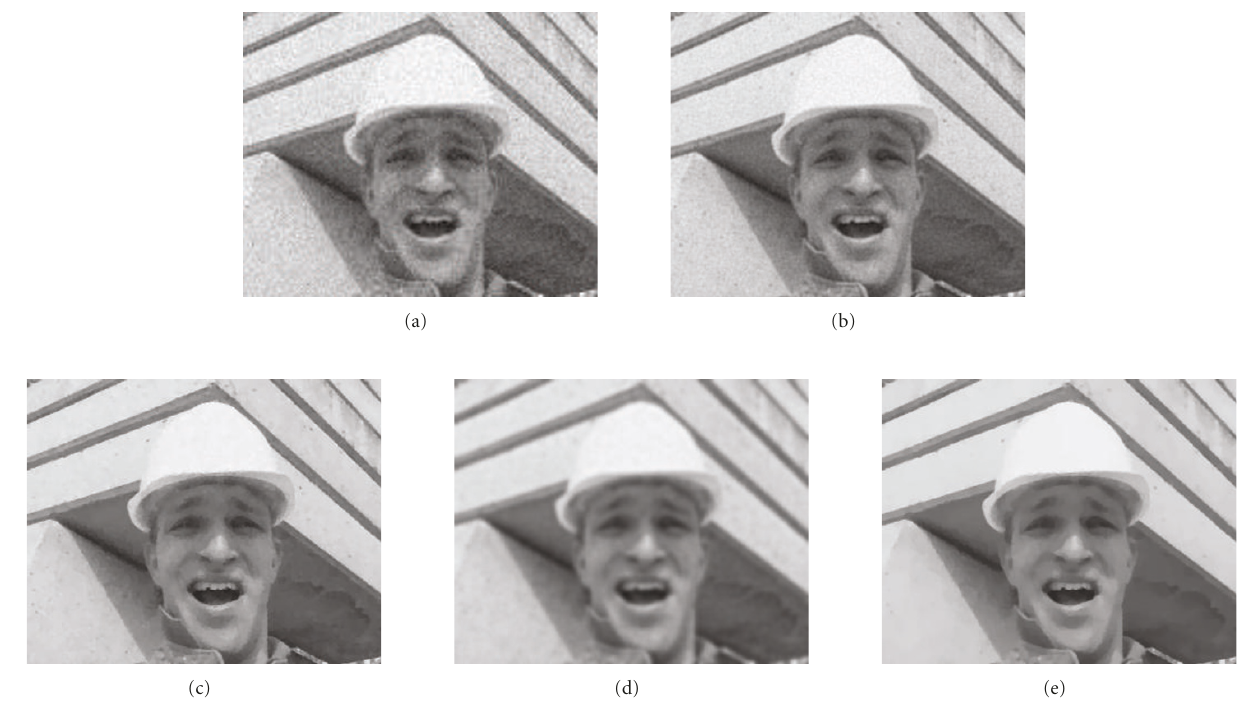
Figure 7: Experimental results in the synthetic “noise” case. (a) LR frame, (b) Laplacian SR result with λ 2 = 0 . 1024, (c) TV SR result with λ = 3 . 2768, (d) Laplacian SR result with λ 2